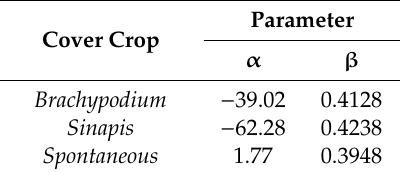
Table 7. Linear relationship between residual C and aboveground residue amount. Parameter Cover Crop α β Brachypodium − 39.02 0.4128 Sinapis − 62.28 0.4238 Spontaneous 1.77